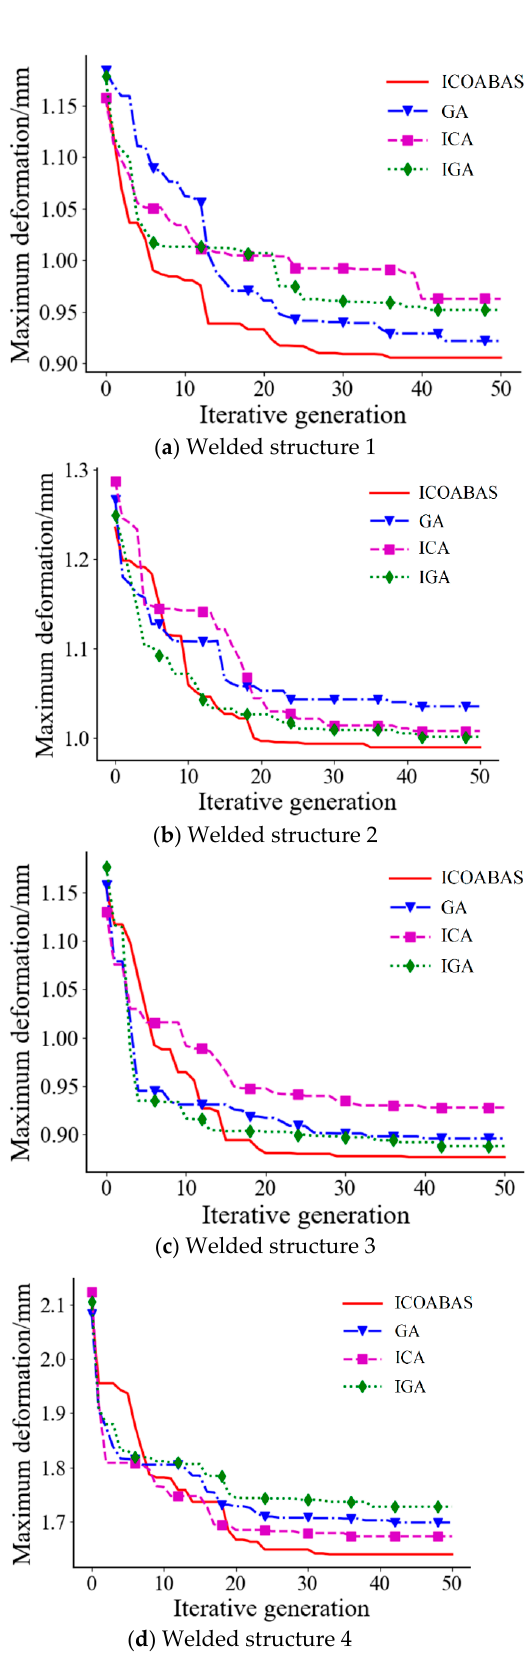
Figure 11. Maximum deformation evolution curves of four algorithms in four structures.